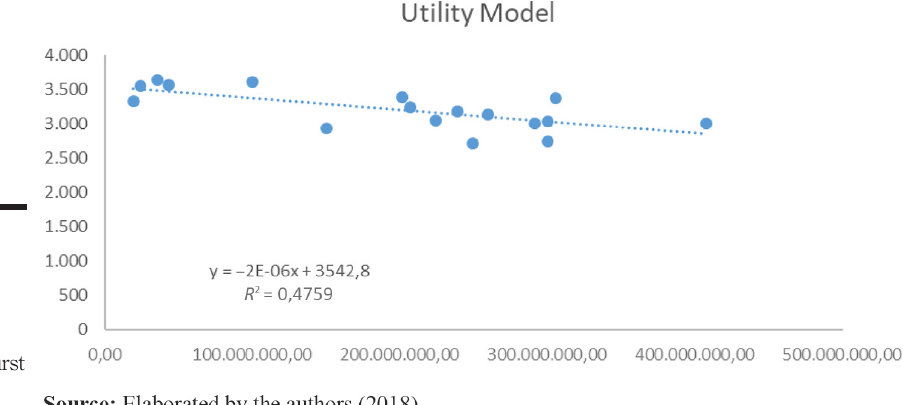
Regression statistics